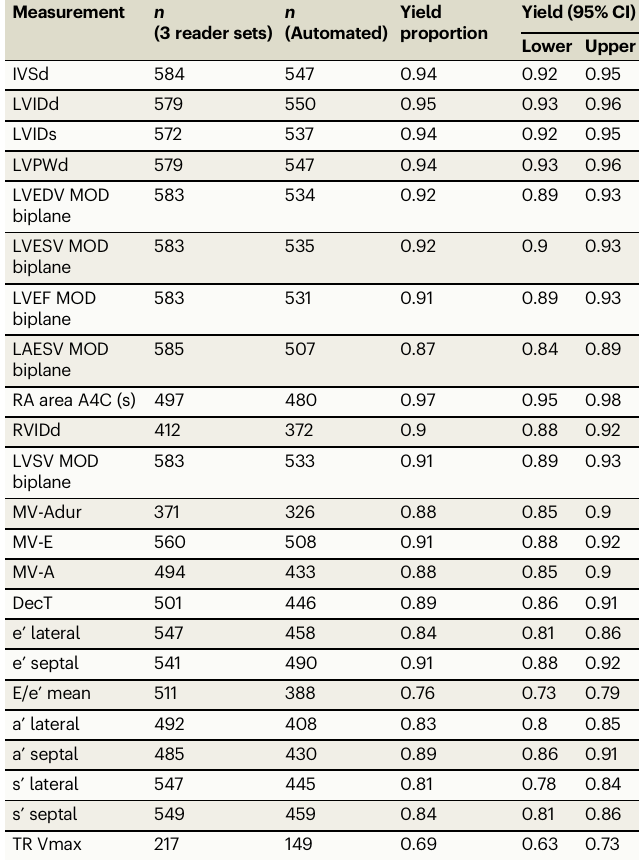
DecT decelerationtimeofearly diastolic MV transmitral fl ow, IVSd interventricular septal dia- meterenddiastolic, LAESVMODbiplane leftatrialendsystolicvolumebiplanecalculationbased onmethodofdiscs, LVEDVMODbiplane leftventricularenddiastolicvolumebiplanecalculation basedonmethodofdiscs, LVEFMODbiplane leftventricularejectionfractionbiplanebasedon method ofdiscs, LVESVMODbiplane left ventricular endsystolic volume biplane calculation based on method ofdiscs, LVIDd left ventricular internal diameterat end diastole, LVIDs left ventricular internal diameterat end systole, LVPWd left ventricular posteriorwall thickness measured end diastolic, LVSV MODbiplane left ventricular stroke volume biplanecalculation basedonmethodofdiscs, MV-A latediastolictransmitral fl ow, MV-Adur durationoflatediastolic transmitral fl ow, MV-E earlydiastolictransmitral fl ow, RAareaa4c rightatrialareaatendsystole in A4C, RVIDd right ventricularend diastolicinternal diameter, TR Vmax tricuspid regurgitation maximum